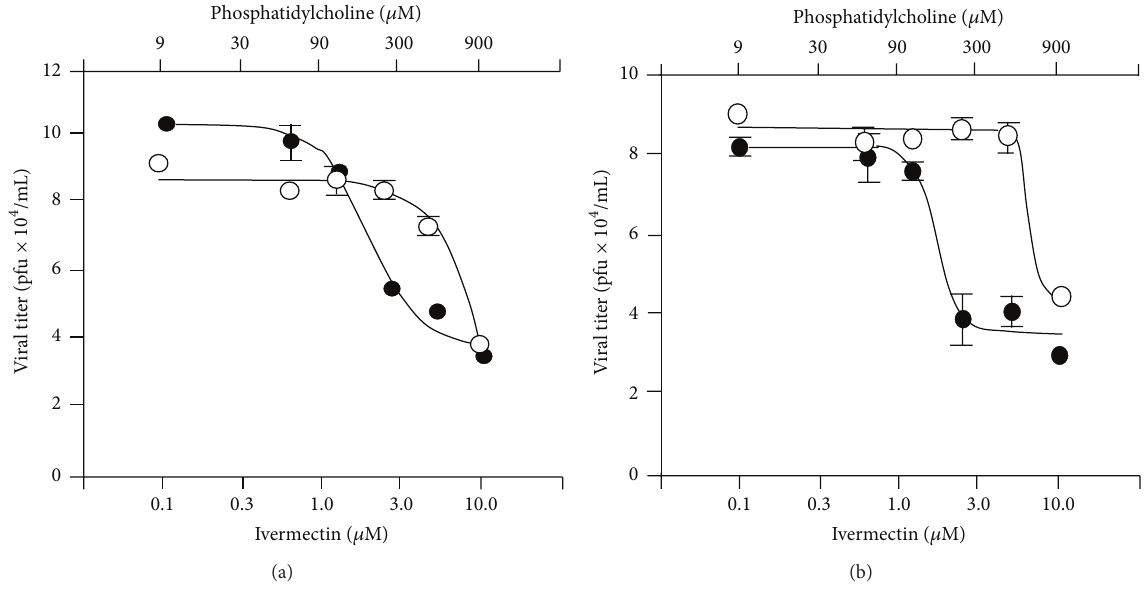
Figure 12: In vitro antiviral effect of ivermectin formulated in liposomes (closed circles) on Huh-7 cells infected with DENV 2. The following liposomal formulations were tested: #PC9-Ch1-ive1.0 (a) and #PC9-Br1-ive1.0 (b). For comparison, the infected cells were treated with the empty liposomal formulations (open circles). The phosphatidylcholine concentration (top 𝑥 -axis) is related to empty liposomes while the ivermectin concentration (bottom 𝑥 -axis) is related to ivermectin liposomes. Details on the identification codes and liposomal compositions are included in Table 1. Details on the EC 50 values are in Table 3. Data represent the average of 2 determinations ±